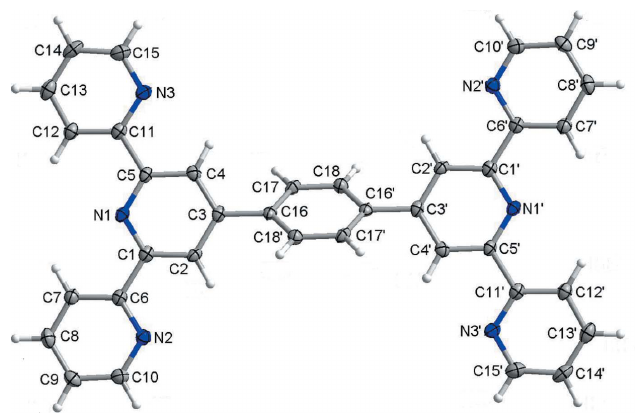
Figure 1 The molecular structure of the title triclinic polymorph (Form I), with atom labelling [symmetry code (’): (cid:4) x , (cid:4) y , (cid:4) z ]. Displacement ellipsoids are drawn at the 50% probability level.